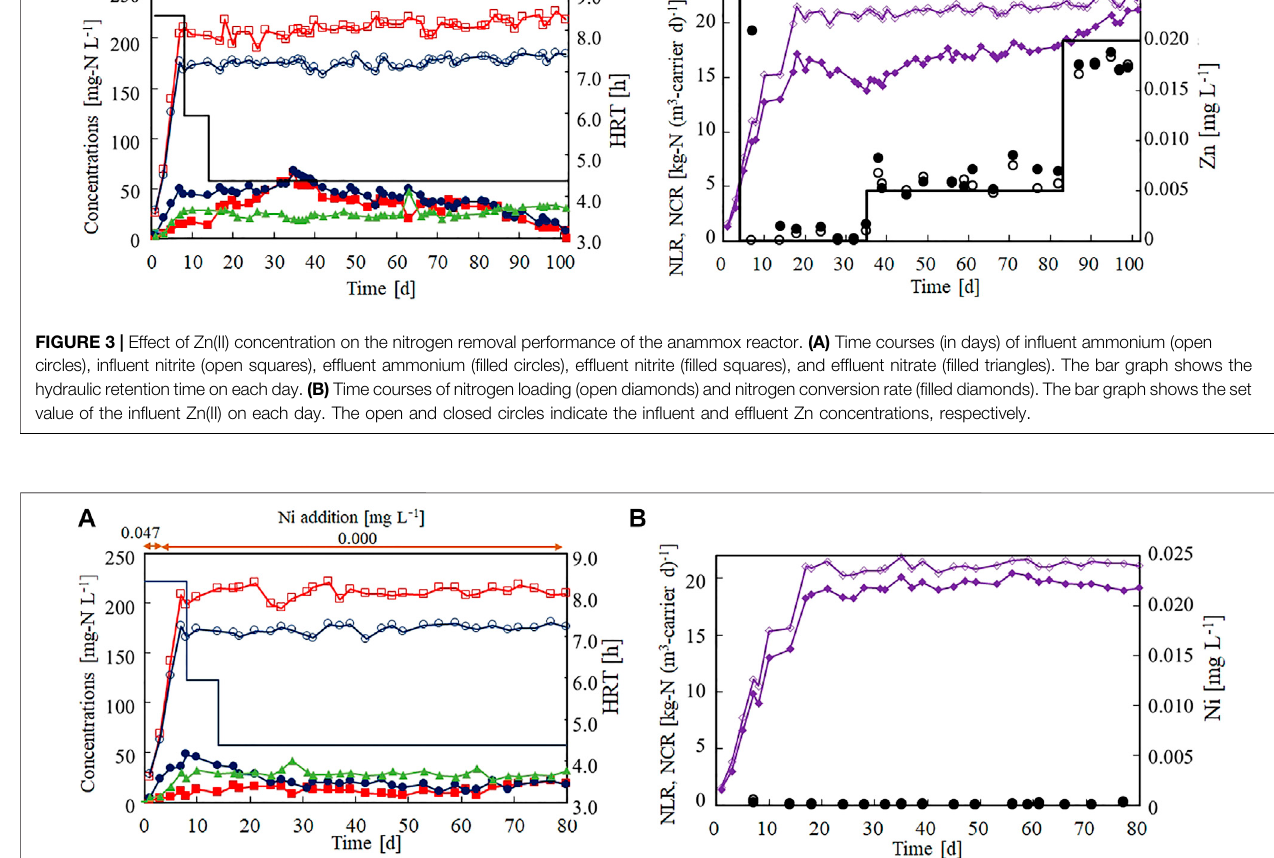
Frontiers in Bioengineering and Biotechnology |